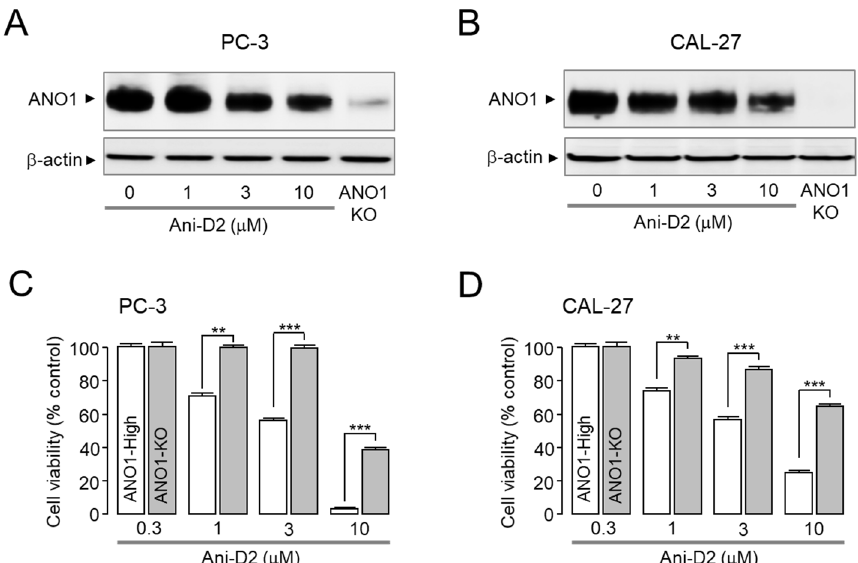
Figure 5. E ff ect of Ani-D2 on protein expression levels of ANO1 and cell viability in PC-3 and CAL-27 cells. ( A , B ) Representative Western blot analysis of ANO1 in Ani-D2 treated PC-3 and CAL-27 cells expressing ANO1 (three independent experiments performed). Cells were cultured with the indicated concentrations of Ani-D2 for 24 h. ANO1 knockout (KO) cells were established using CRISPR / Cas9 technique. ( C , D ) E ff ect of Ani-D2 on cell viability in PC-3, ANO1 KO PC-3, CAL-27, and ANO1 KO CAL-27 cells. Ani-D2 was treated at the indicated concentrations for 72 h, and cell viability was determined using MTS assay kit (mean ± S.E., n = 5). ** p < 0.01, *** p < 0.001. To verify whether Ani-D2 inhibits migration of the cancer cells, a cell wound healing assay was performed on PC-3 and CAL-27 cells highly expressing ANO1. Ani-D2 at concentrations of 1, 3, and 10 μ M strongly inhibited the migration in PC-3 cells by 31.3, 68.0, and 88.3%, respectively, and in CAL-27 cells by 31.8, 64.0, and 87.5%, respectively (Figure 6).